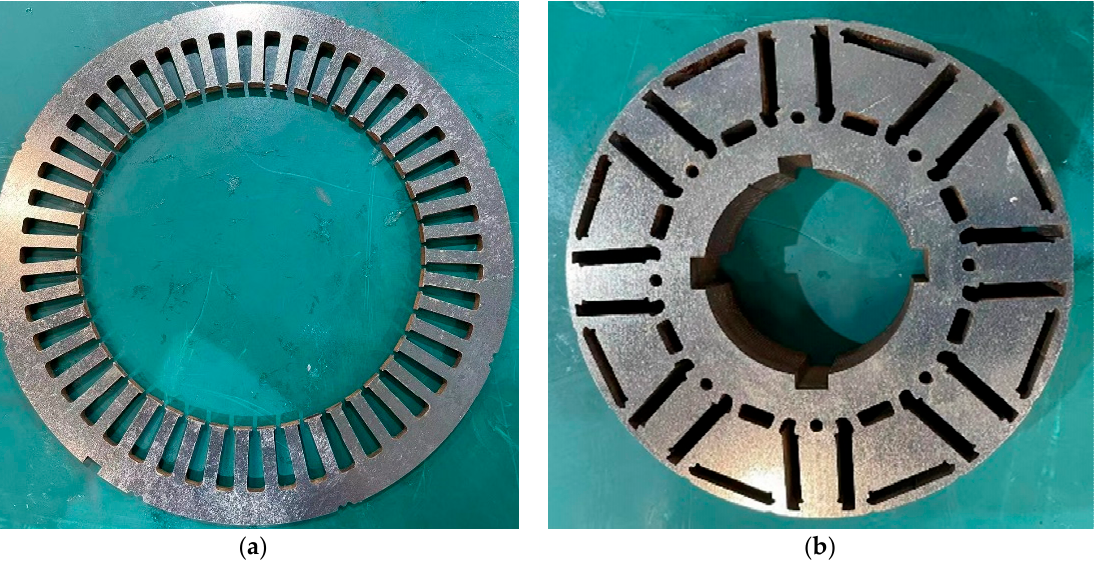
Figure 20. WEDM core of a motor. ( a ) Stator. ( b ) Rotor.